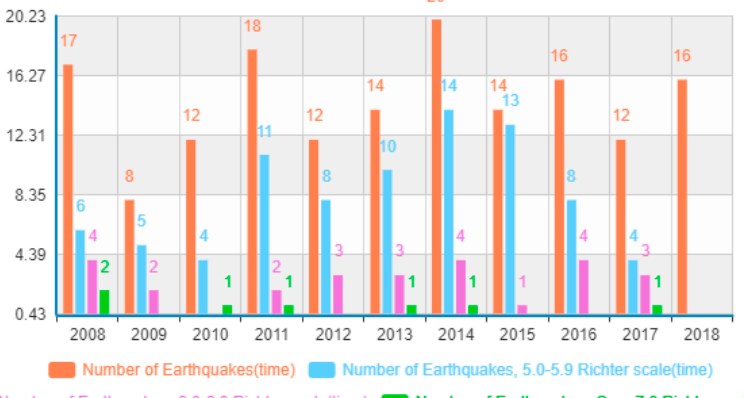
Figure 1. Statistics on the number of earthquakes in China from 2008 to 2018.